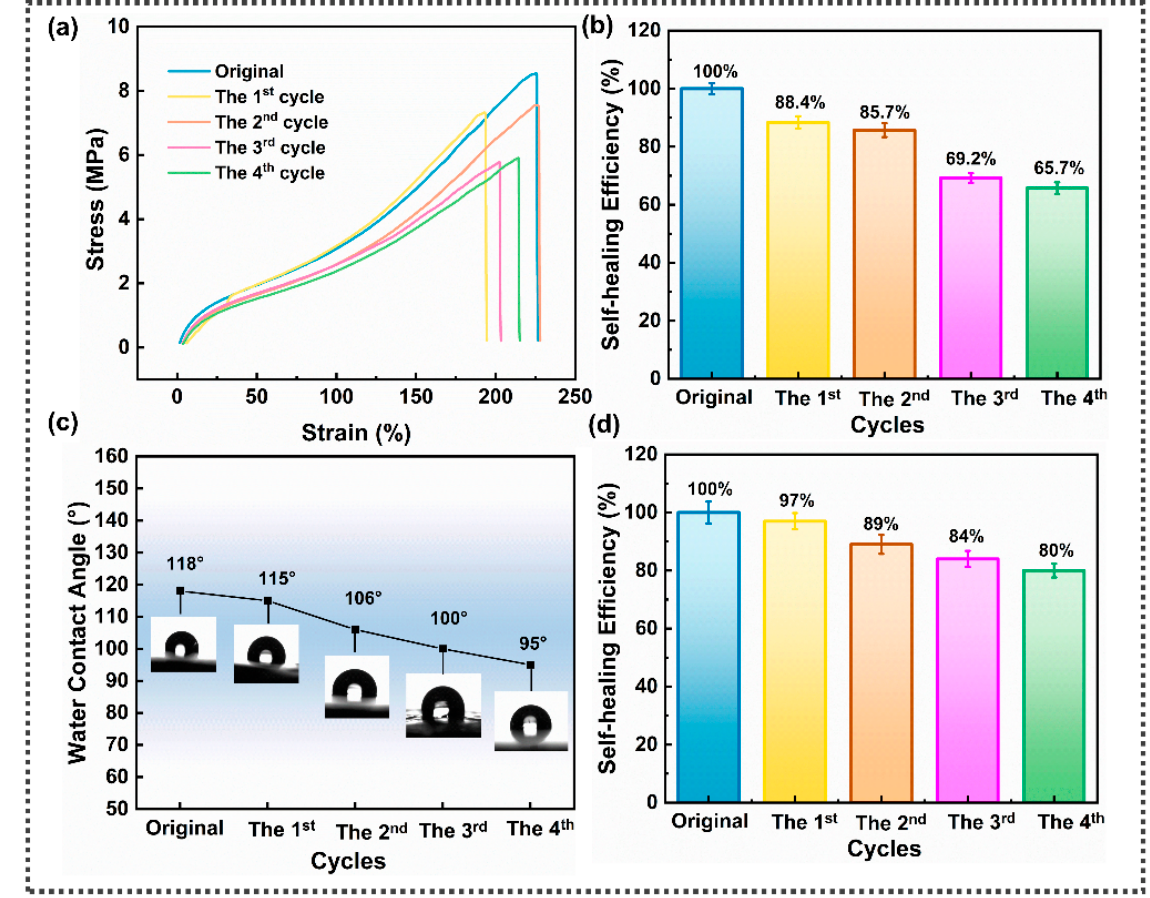
Figure 4. ( a ) Stress-strain curves of the original and repaired SFPUHE-HTF-CNTs; ( b ) the mechanical repair efficiency of SFPUHE-HTF-CNTs; ( c ) static water contact angles of the original and repaired SFPUHE-HTF-CNTs; ( d ) the hydrophobic self-healing efficiency of SFPUHE-HTF-CNTs.